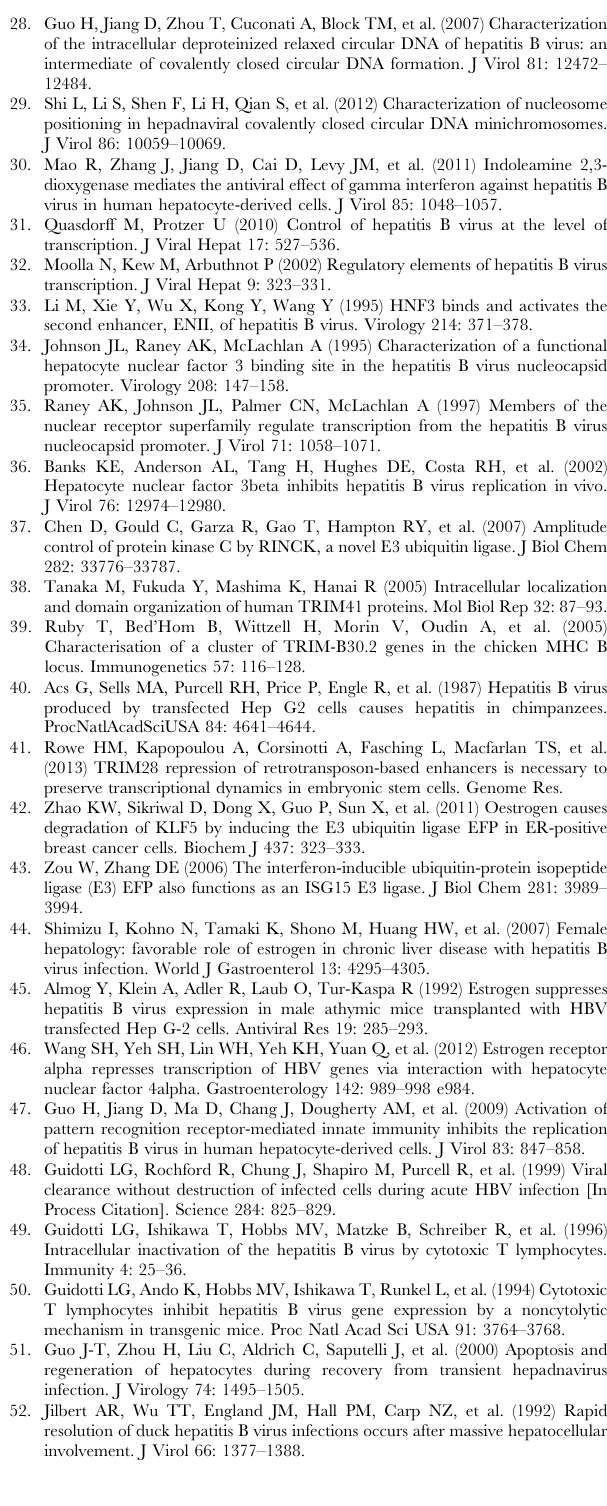
Table S2 Sequence of primers for real time PCR